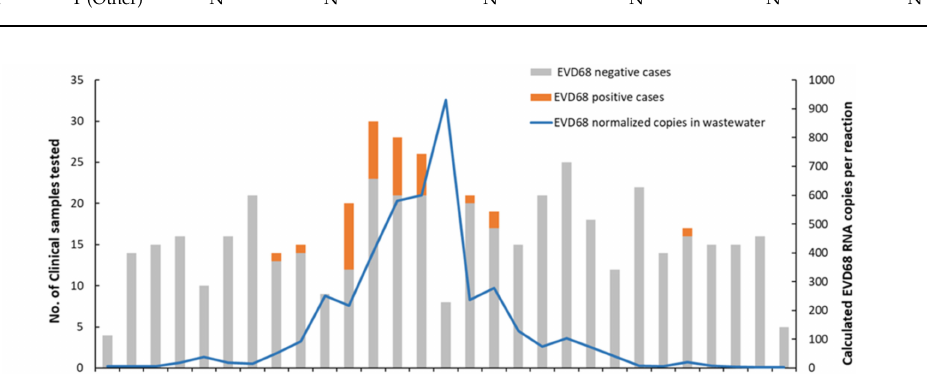
Figure 1. Dynamics of EVD68 circulation in clinical and WW samples. Stacked columns represent the total number of clinical tests for each month, of which the gray column represents the negative and the orange represents the positive. Stacked line represents the calculated number of copies in WW samples, in each week. The left Y -axis refers to the number of clinical samples tested in each week. The right Y -axis represents the calculated average number of copies per reaction in WW samples in each